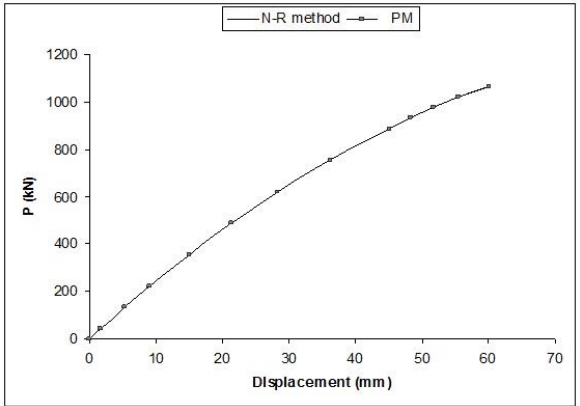
Figure 7. Space truss with 120–members, all dimensions are in mm. Table 3. Comparison of the computational cost and iteration number Decrease Percentage Present Method Newton method